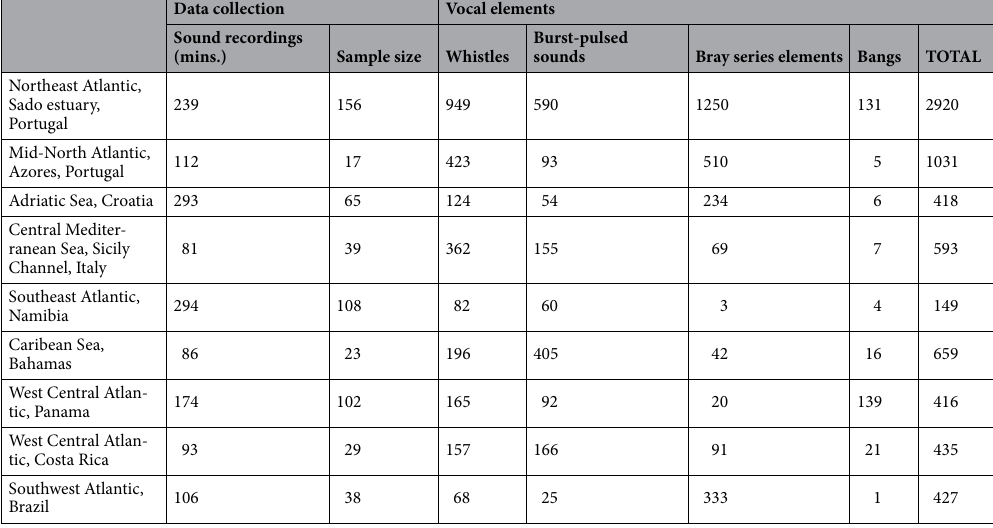
Table 1. Data collection and vocal elements, by